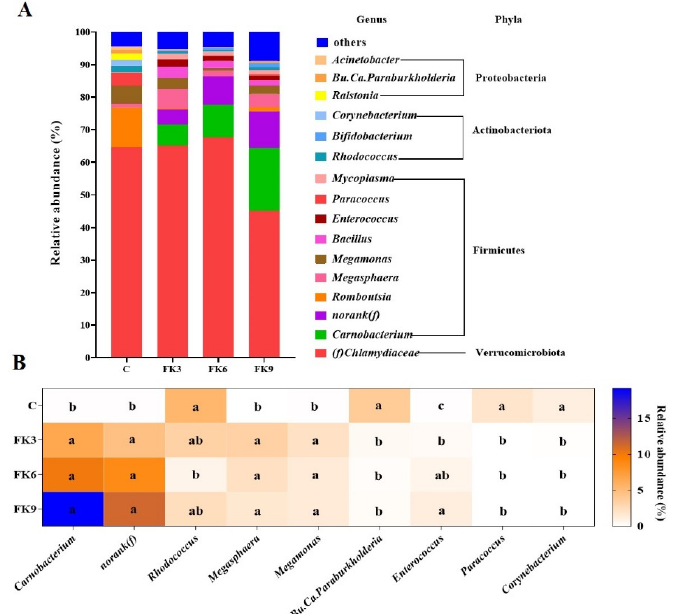
Figure 7. Distal intestinal microbiota composition of largemouth bass fed diets with various FK lev- els. ( A ) The top 16 most abundant taxa at genus level among dietary treatments. The top 16 genera were selected accounting for more than 90% of the total abundance in each treatment. ( B ) The heatmap showing significant difference in the relative abundance of 9 genera between dietary treat- ments ( p < 0.05, means ± SEM, n = 6).